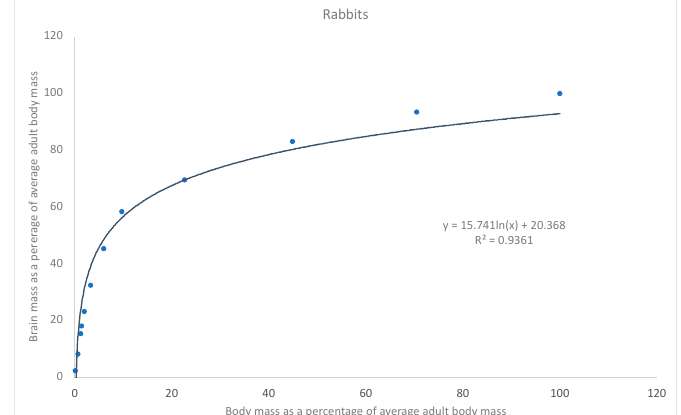
averages of brain and body weights for each age group (N = 2–12).